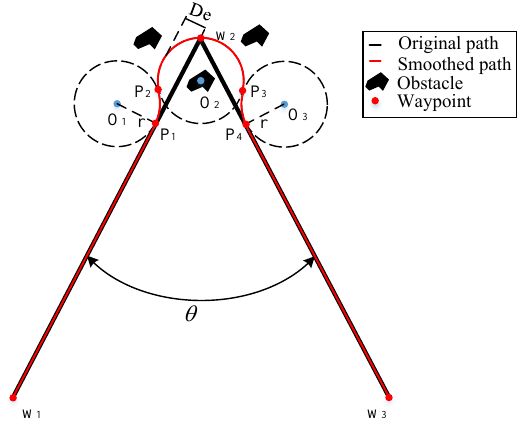
Figure 4. Smoothed path created using the L-3C-L